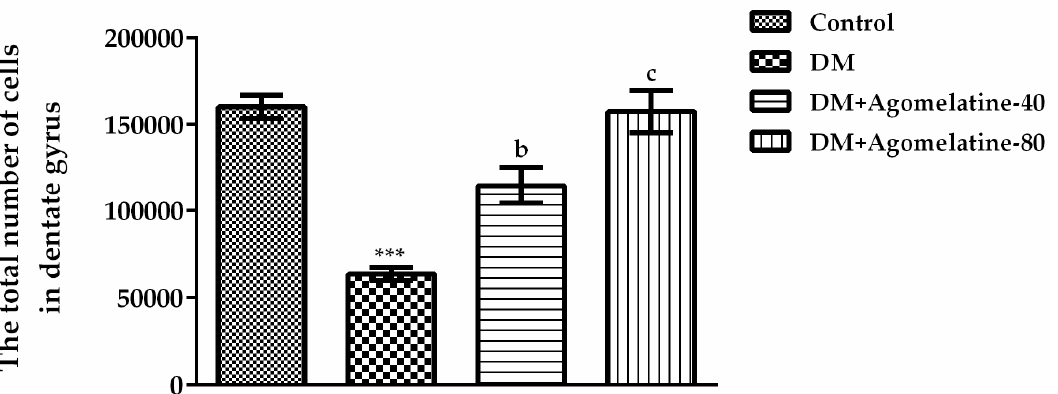
Figure 9. The total number of cells in the dentate gyrus of normoglycemic rats administered saline solution (control) and diabetic rats administered saline (DM), 40 mg/kg agomelatine or 80 mg/kg agomelatine for 2 weeks. Values are given as mean ± S.E.M. Significant difference against control group *** p < 0.001. Significant difference against DM group b p < 0.01; c p < 0.001. One-way-ANOVA, post-hoc Tukey HSD multiple comparison test, n = 6.